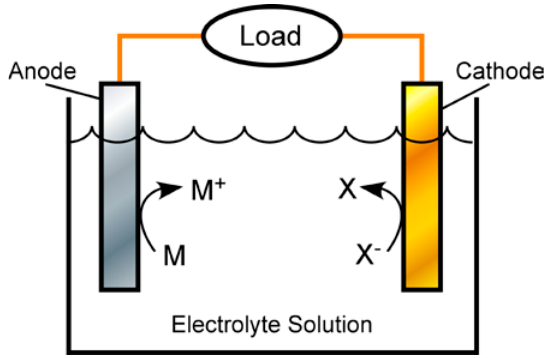
Figure 1. A simple electrochemical